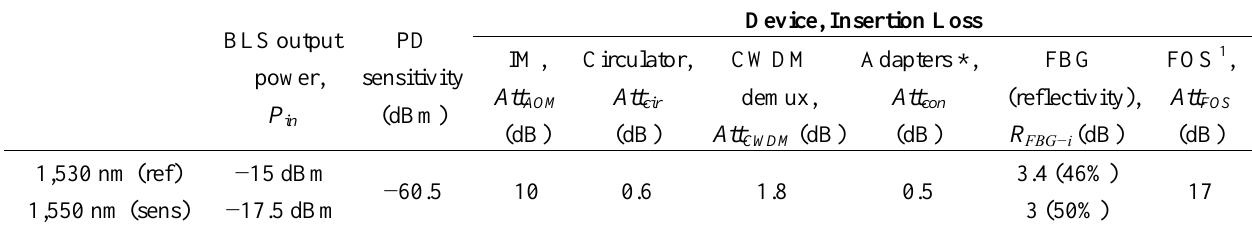
Table 1. Optical power budget analysis of the proposed CWDM-based remote sensing